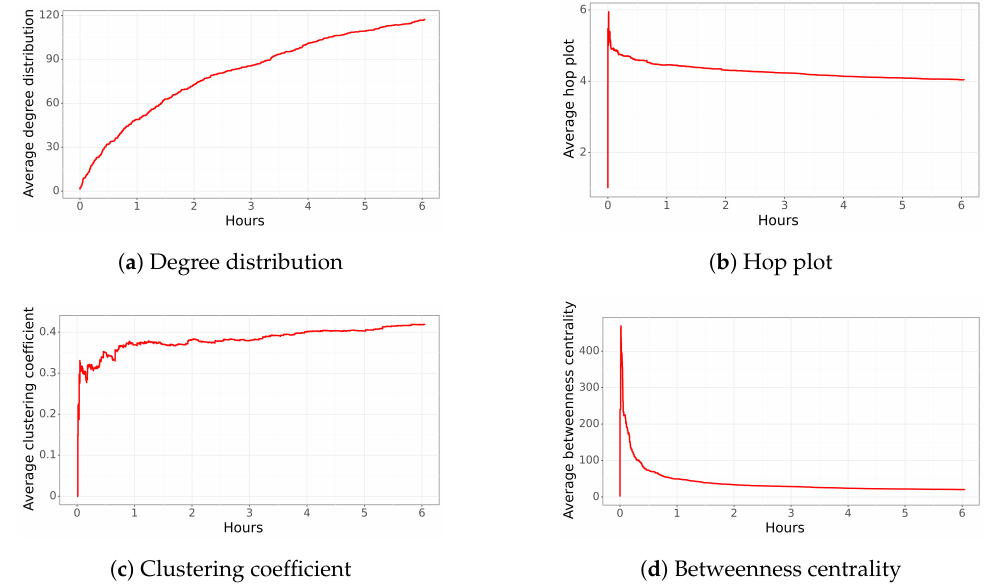
Figure 6. Average network characteristics for the politician over